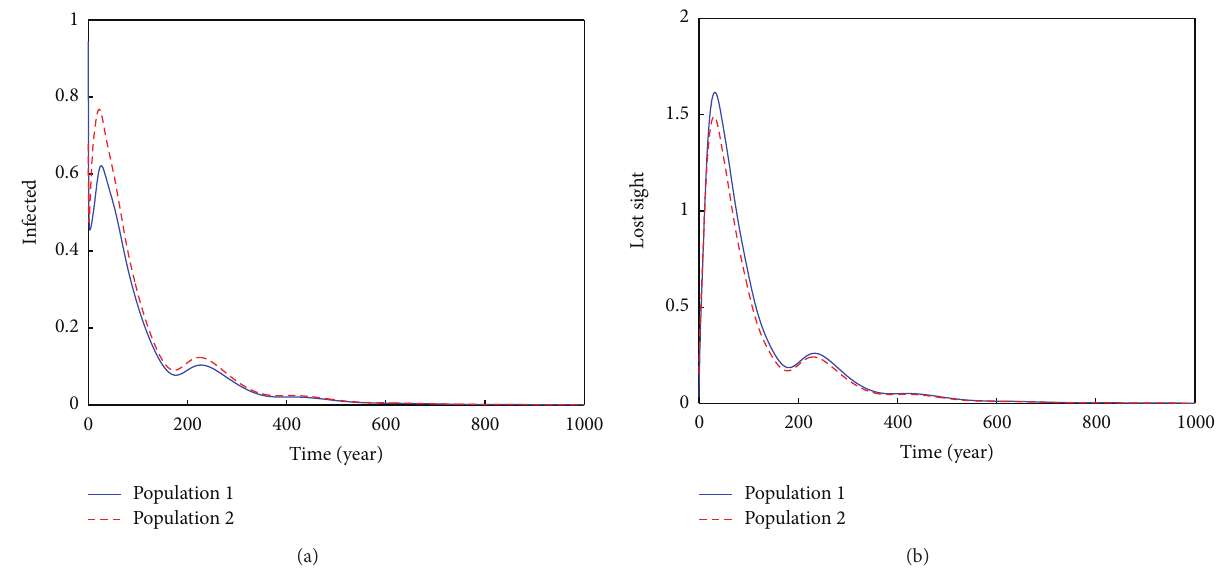
Figure 3: Trajectories of latently infected individuals of (1) for different initial conditions when 𝛽 1 = 0.002 and 𝛽 2 = 0.003 (such that = 0.3691 and 𝑅 2 = 0.4980 ). The latent classes disappear at the end and only susceptible classes persist when 𝑅 𝑅 1 0 0 are as in Table 1.